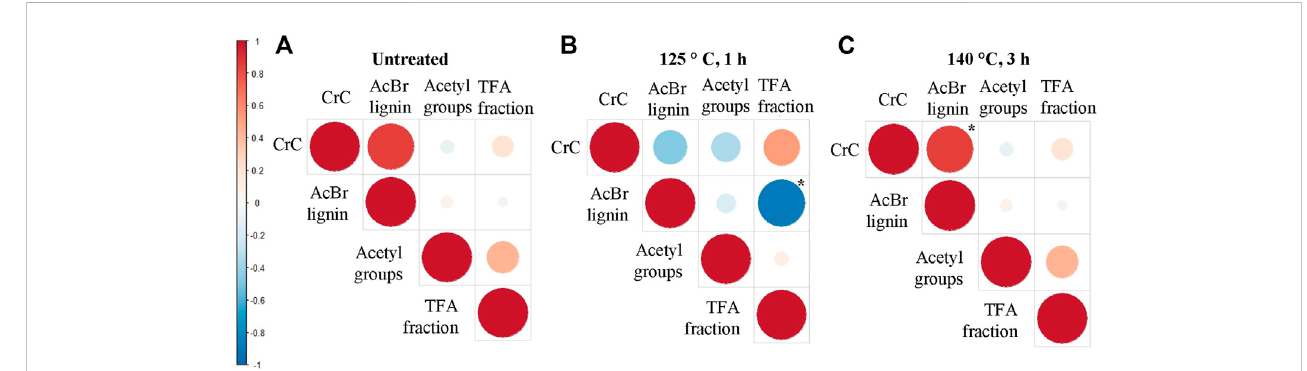
FIGURE 7 Correlation analysis of the biochemical features obtained from (A) initial and pretreated rapeseed straw at (B) low and (C) high severity. Pearson correlationfactors werecalculatedforCrC,acetylgroups,AcBr-Lignin,andtotalsugarcontentoftheinitial biomassandpulpbiomassyieldatlow(125 ° C,1 h) and high severity (140 ° C, 3 h). Positive correlations are depicted in red circles, and negative in blue. The size of the circle re fl ects the value of the correlation factor r. * Statistically signi fi cant ( p <